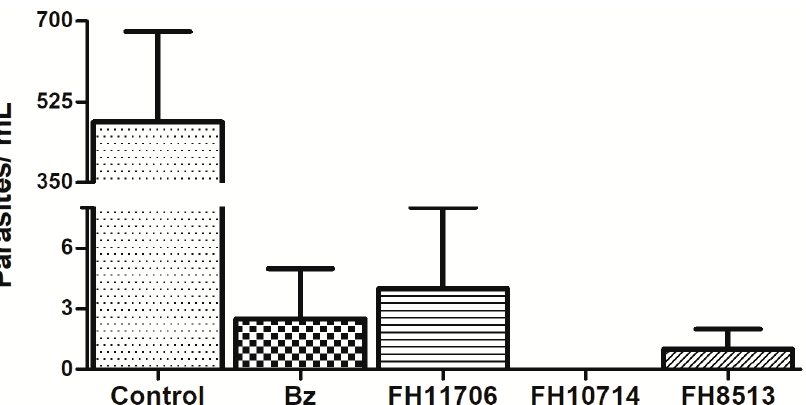
Figure 4. Light microscopy quantification of parasites released into the supernatant of L929 infected with T. cruzi (Tulahuen strain) after washout assay. Values are the average of two independent determinations. All compounds were statistically significative ( p > 0.05) compared to untreated cultures (control).